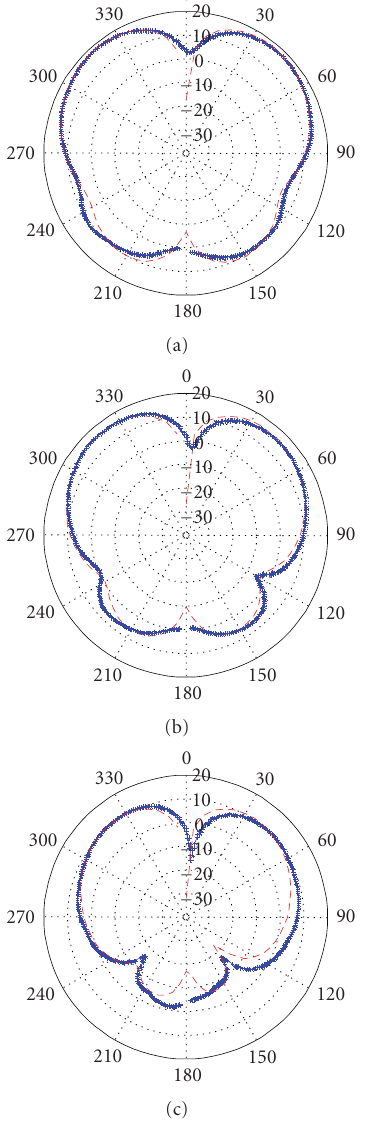
Figure 7: Measured (+) and simulated ( − ) cross-polarized radia- tion patterns for conical mode ( S 22) in XZ plane at (a) 1.7 GHz, (b) 1.85GHz, and (c) 2.1 GHz.